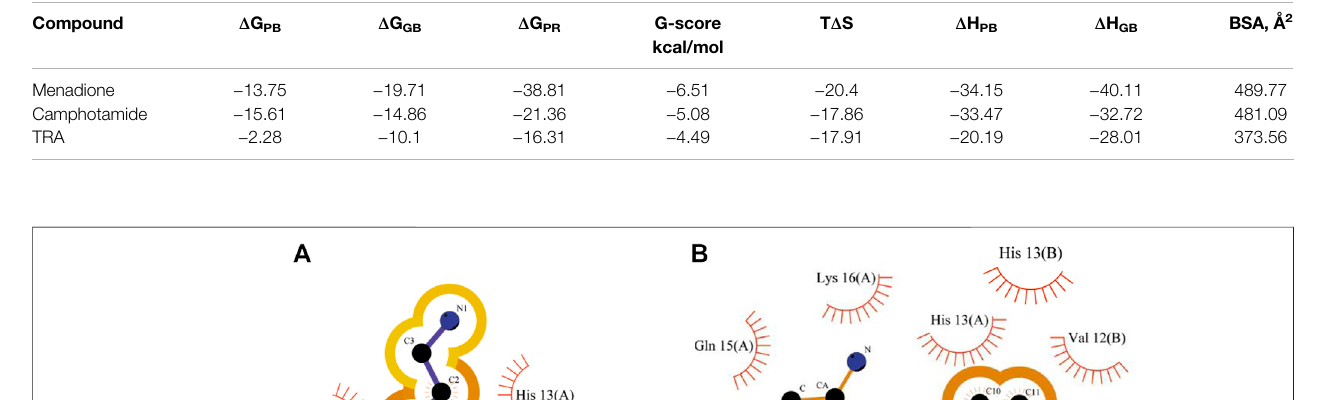
Frontiers in Chemistry |